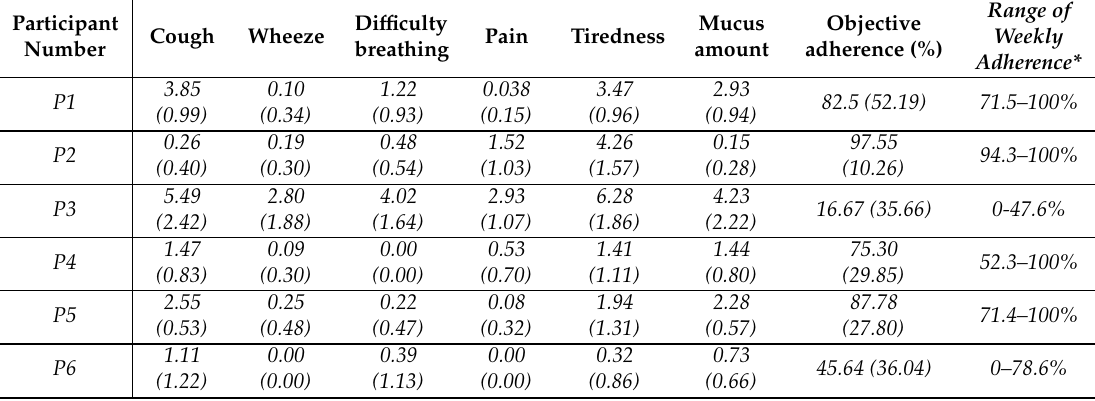
Table 4. Means (standard deviations) for symptom scores and